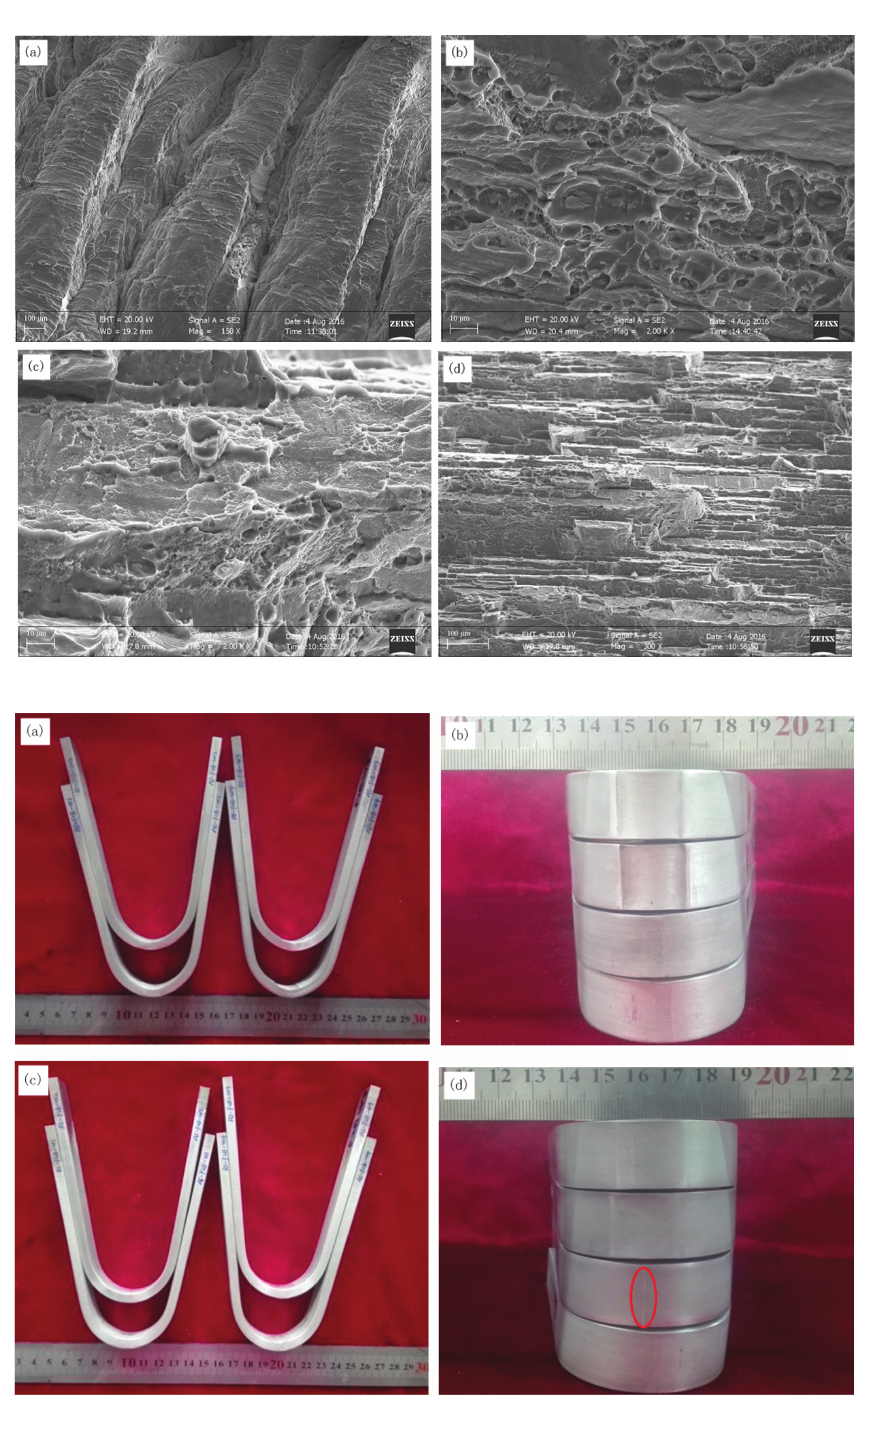
Figure 6: The specimens for bending test:(a) (b) once repair welding; (c) (d) twice repair